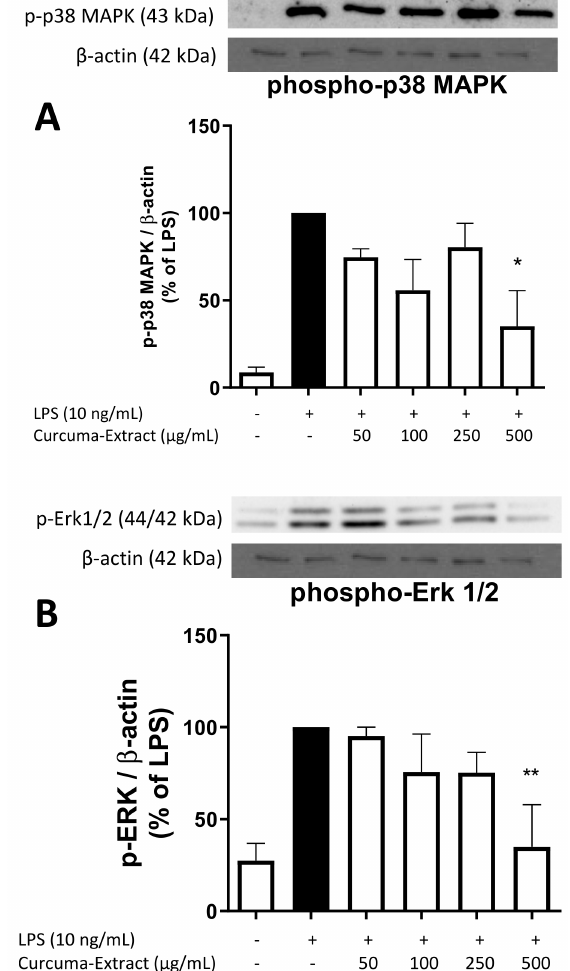
Figure 5. Effects of TE on p38 MAPK ( A ) and Erk 1/2 ( B ) phosphorylation in LPS-stimulated BV2 cells. TE was added 30 min before stimulation with 10 ng/mL LPS for 30 min. Western Blot analysis was performed for p-p38/MAPK ( A ) and phospho-Erk 1/2 ( B ). Values are presented as the mean ± SEM of at least three independent experiments, and protein levels were referenced to β -actin. Statistical analyses were performed using one-way ANOVA with Bonferroni post hoc test and * p < 0.05 and ** p < 0.01, compared to